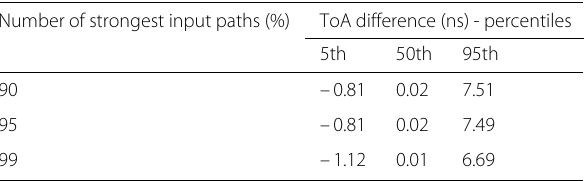
number of strongest input propagation paths Number of strongest input paths